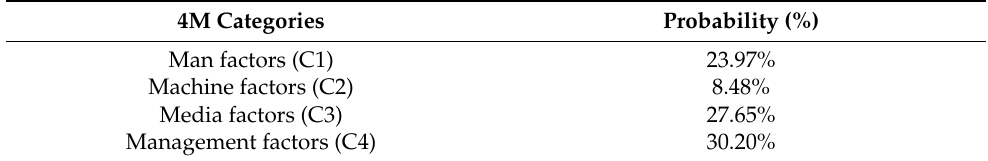
Table 4. Probabilities of 4M categories.